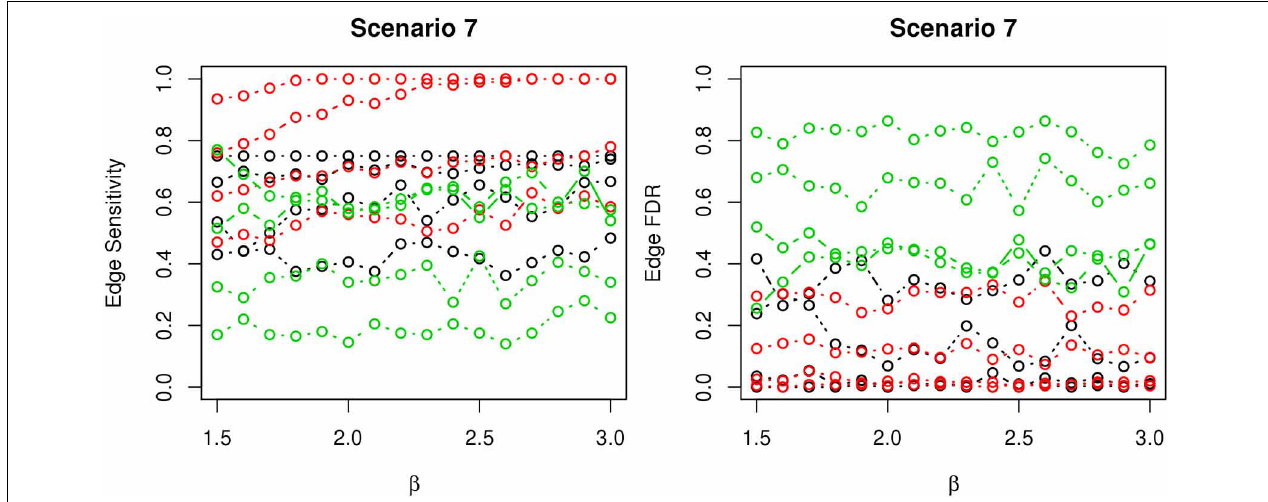
FIGURE 9 | The sensitivity and FDR of edge comparisons in simulation scenario 7. The same legend is used as in Figure 6 . nPARS has higher edge sensitivity and lower edge FDR than GreedyE in these scenarios.